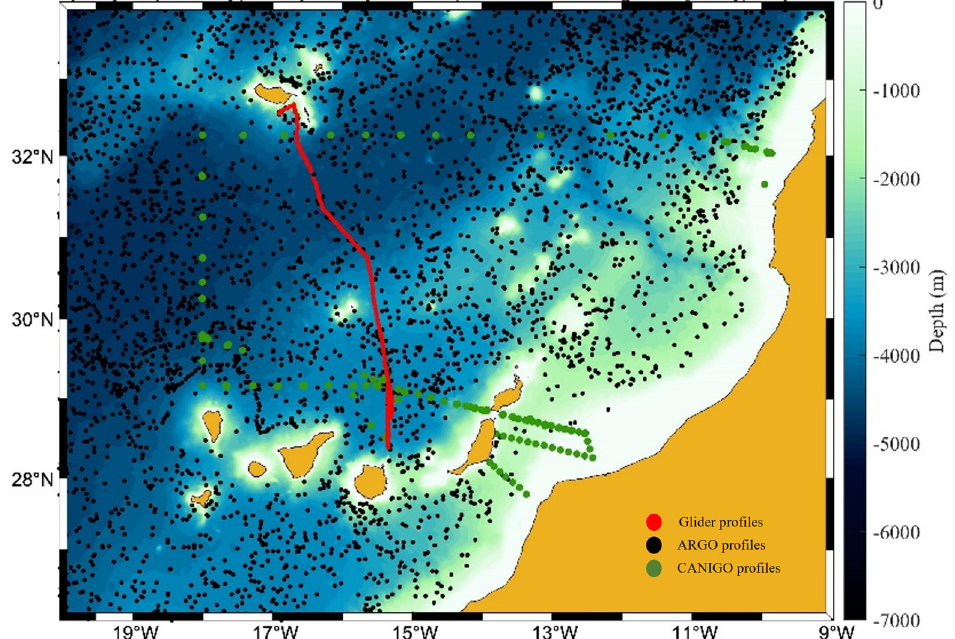
Table 1. Oceanographic cruises and ARGO data used to validate glider observations.